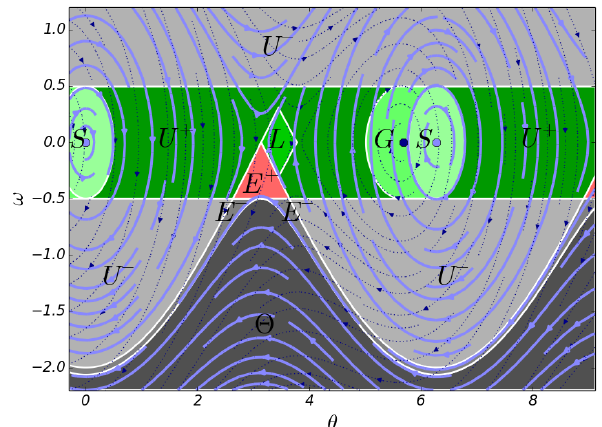
Figure 8. Gravity pendulum fun ride with management by one- sided acceleration and undesirable fast rotations. The 2 π -periodic coordinate θ is the pendulum’s inclination angle. If its angular ve- locity ω exceeds ± (cid:96) , people get sick (grey region). Since staying in L (balancing almost upright) or G (balancing somewhat inclined) is more exciting than in S (resting downward), we have both a glade and a lake